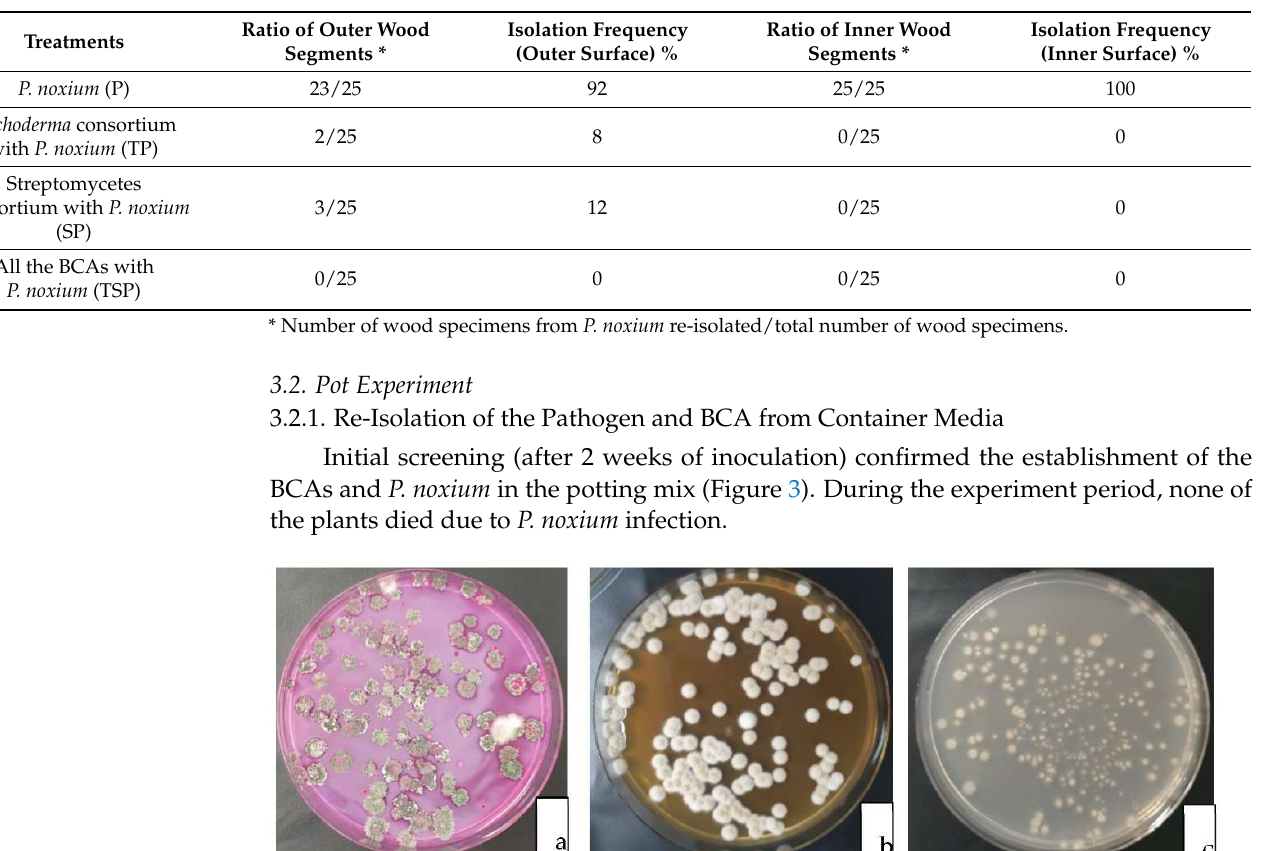
Table 2. Re-isolation frequency of P. noxium from the outer and inner surface of wood blocks treated with P. noxium.